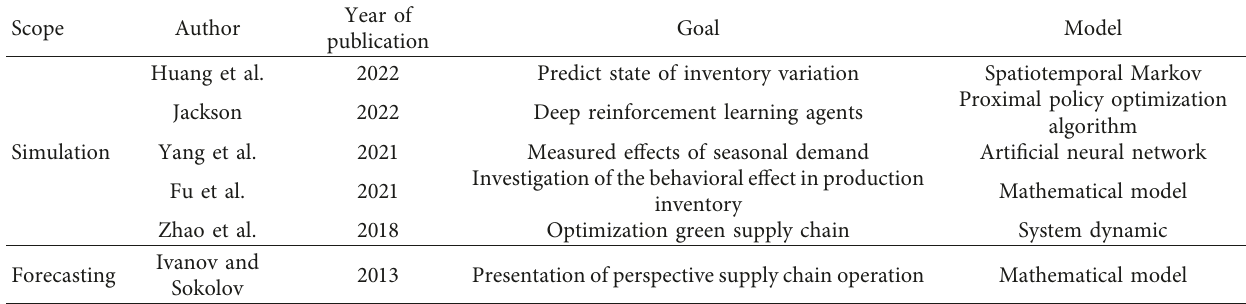
Table 1: Paper classification.